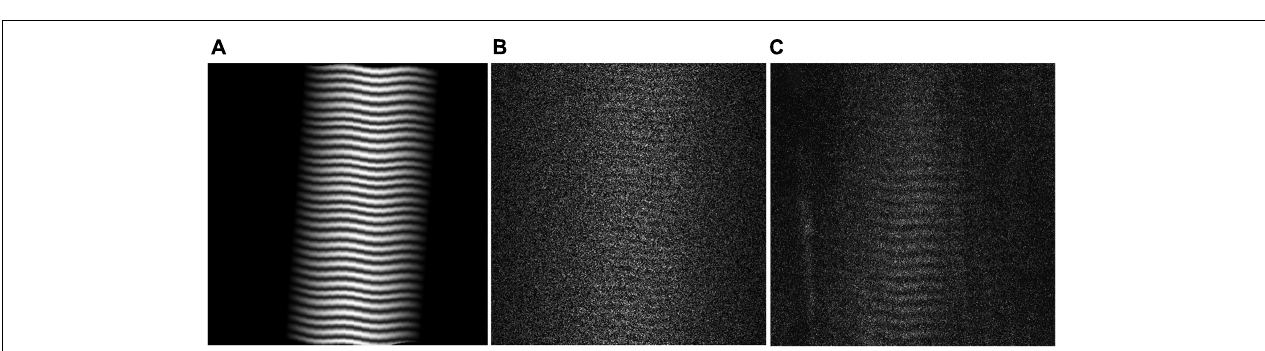
FIGURE 2 | (A) Virtual Phantom created with real sarcomere lengths and variability, distortion, and rotation. (B) Realistic Virtual Phantom with added noise. (C) Representative raw data from in vivo biceps brachii.